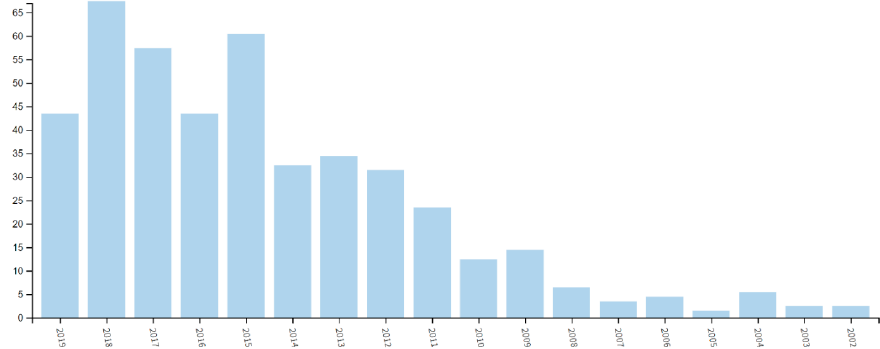
Figure 2. Institute for Scientific Information (ISI) Web of Knowledge (WOK) activity based on records for the “Smart Furniture” phrase in the Title, Abstract and Keywords. Table 1. Top ten journals for “Smart ICT Solution” AND “Elderly” in ISI WOK. (Where ICT stands for information and communication